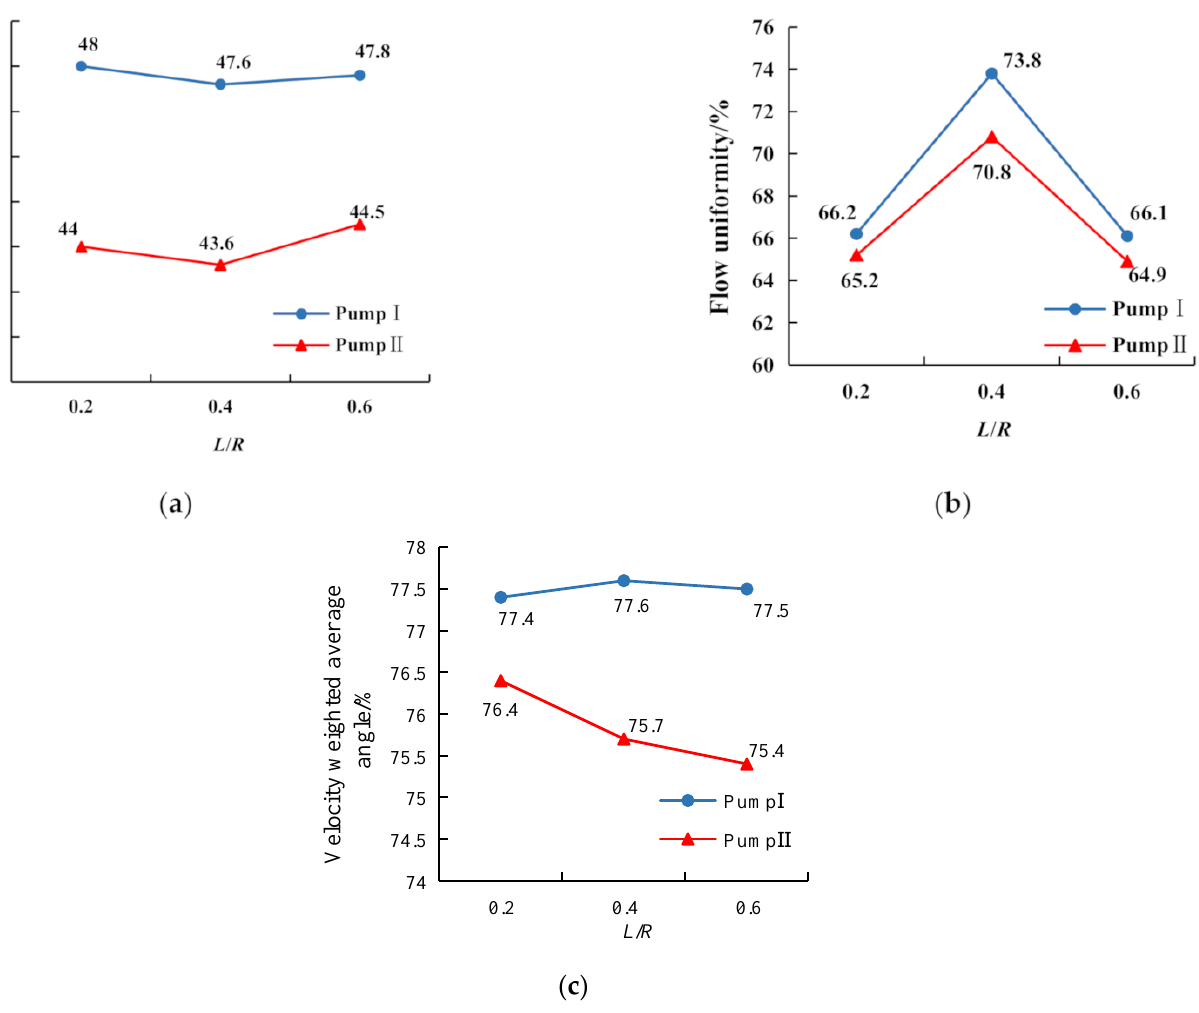
Figure 5. ( a ) The influence of L on the efficiency of the two pumps; ( b ) Variation of the inlet velocity uniformity of the pump impeller chamber with L ; ( c ) The weighted average angle of the inlet velocity of the pump impeller chamber with L.